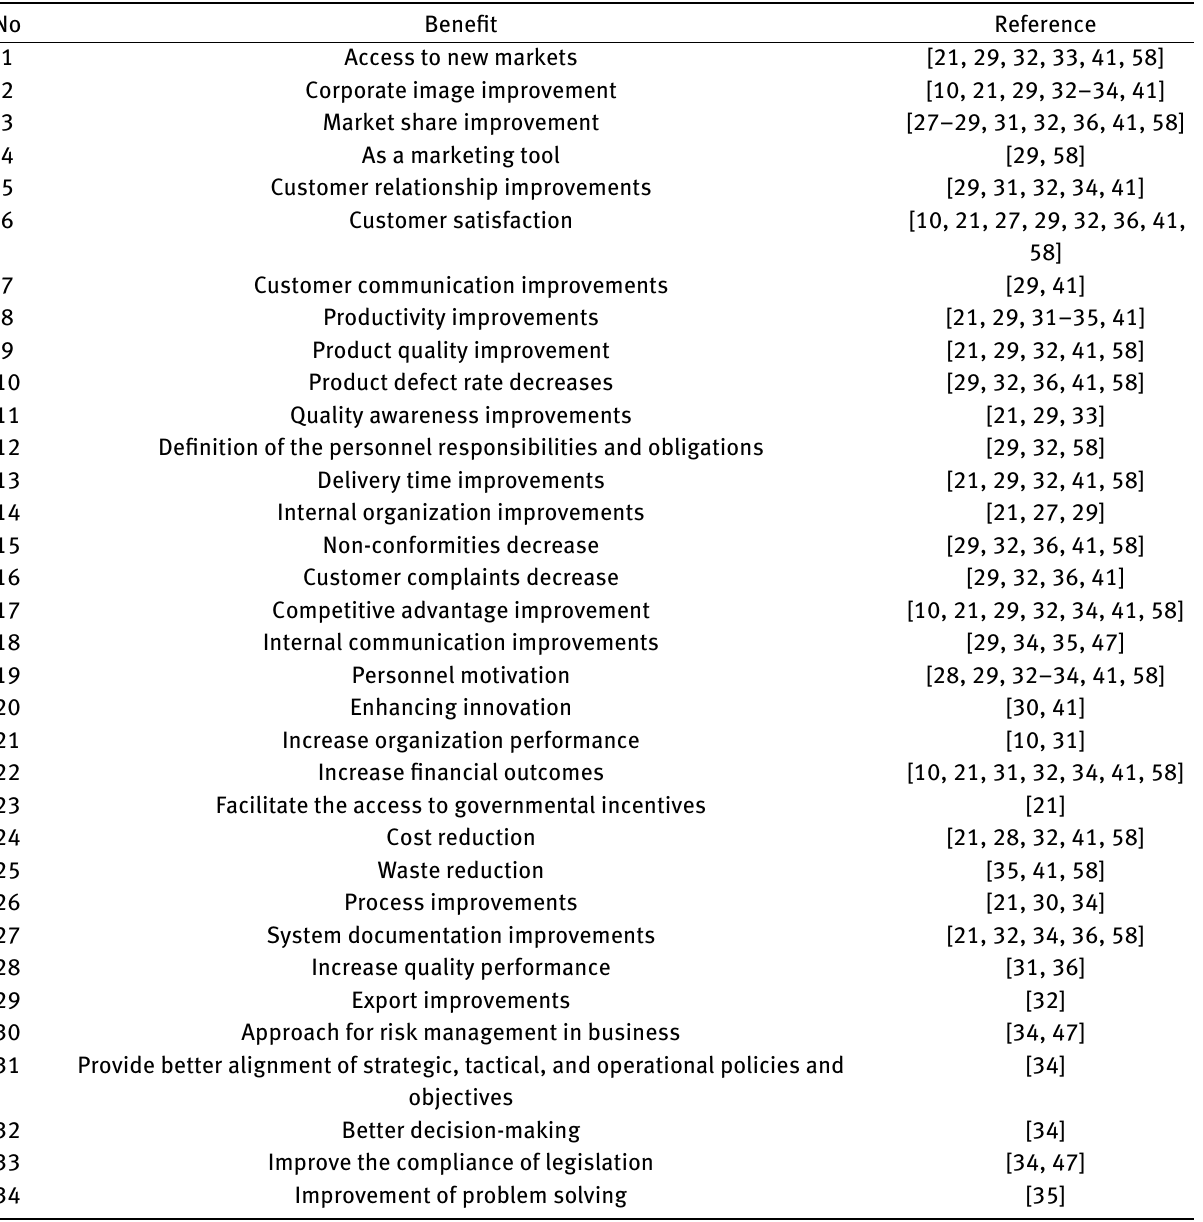
Table 3: Benefits of system and product certification